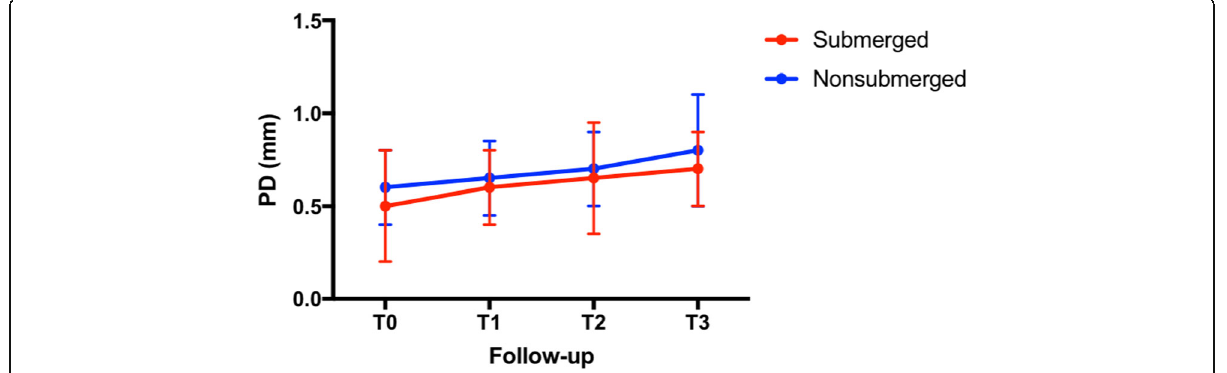
Fig. 5 Mean values of probing depth (PD) between the two groups during the follow-up period. ANOVA test P >